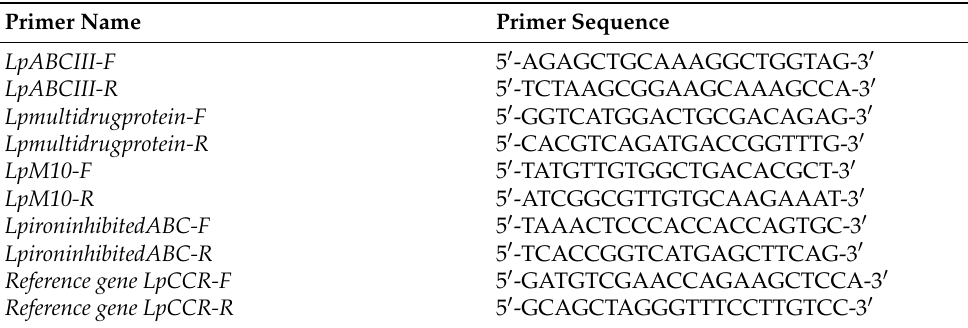
Table 2. Primers used for the quantitative polymerase chain reaction (qPCR) analyses for the four different ABC-transporter genes of interest and reference